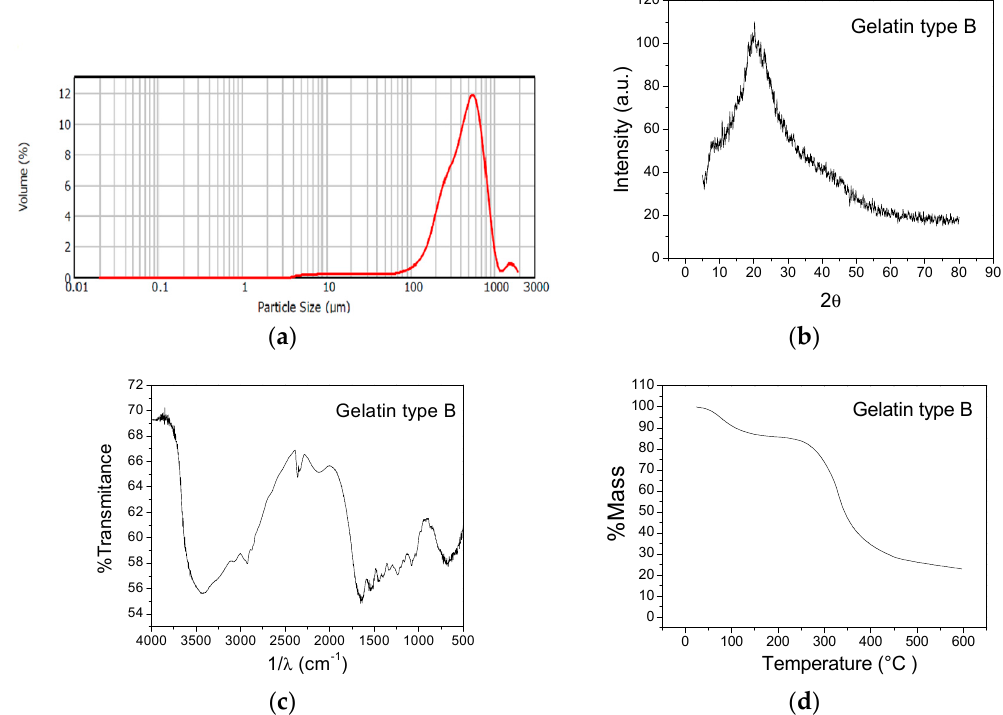
Figure 1. Structural and thermal characterization of type B gelatin. ( a ) Particle size distribution; ( b ) X-ray diffractogram; ( c ) FTIR spectrum; and ( d ) TGA thermogram.